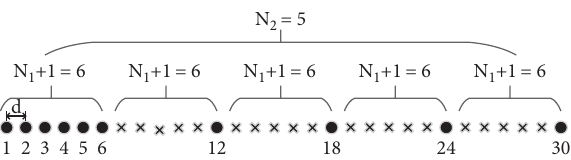
Figure 1: The structure of two-level nested arrays.